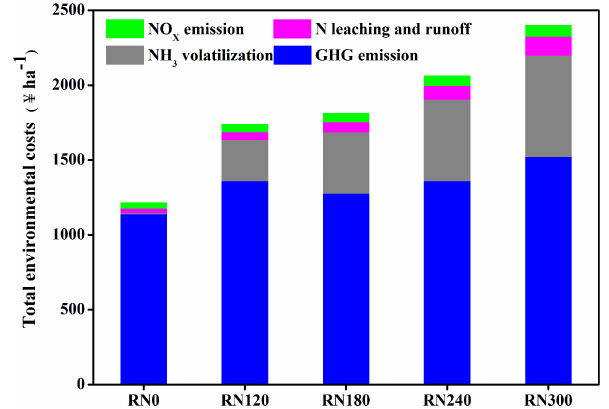
Figure 5. Seasonal average total environmental costs incurred by greenhouse gas (GHG) emissions and reactive N (Nr) losses for rice production in Taihu Lake